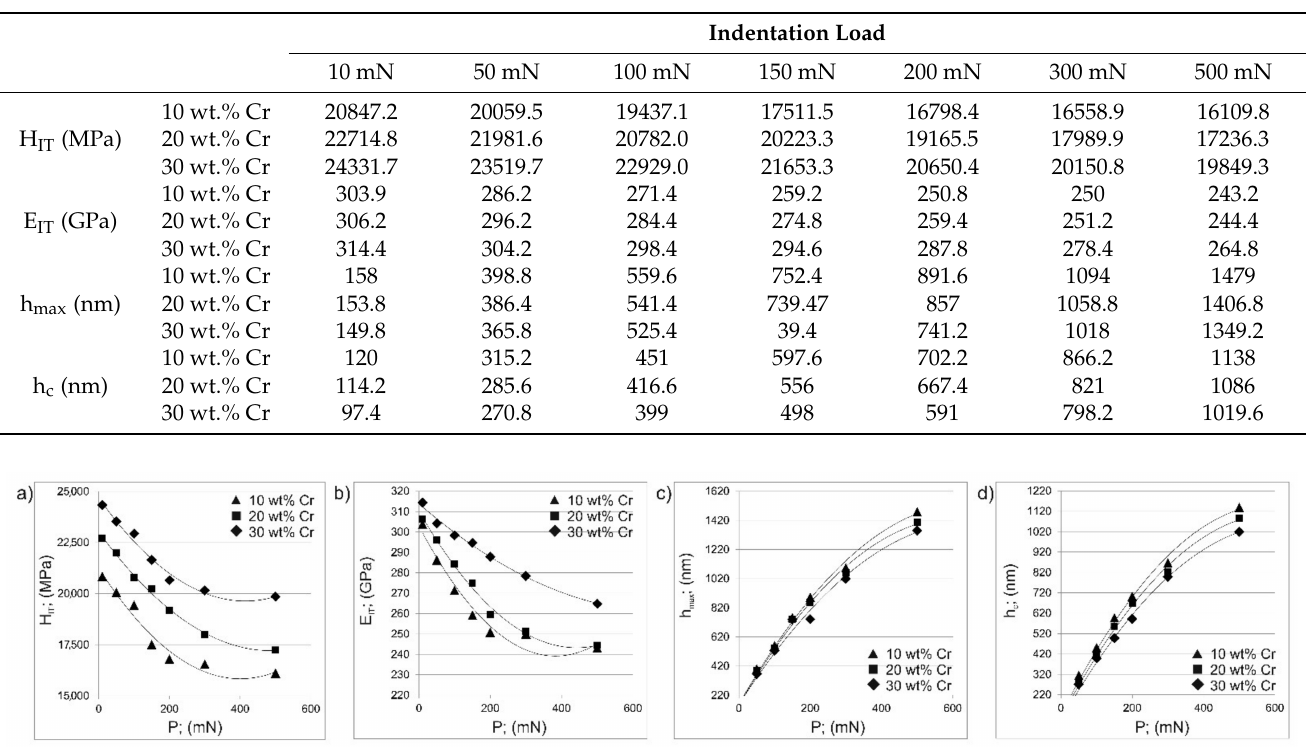
Table 2. The results of the nanoindentation measurements carried out under a load of 10–500 mN obtained in the borided layer in the measuring area containing 10, 20 and 30 wt.% of chromium.